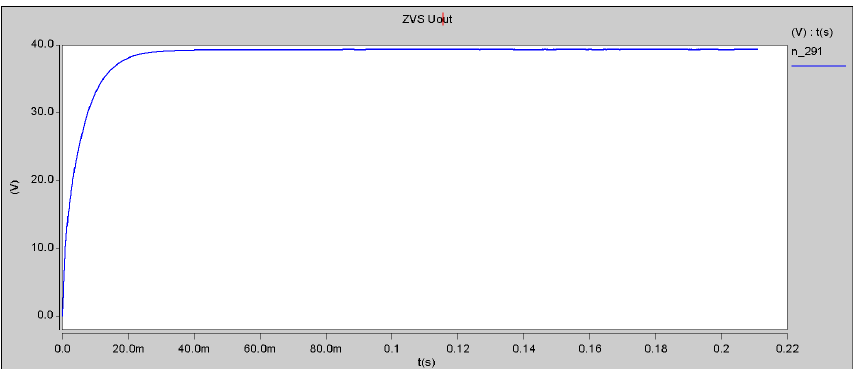
Figure 12. The output waveform of the power